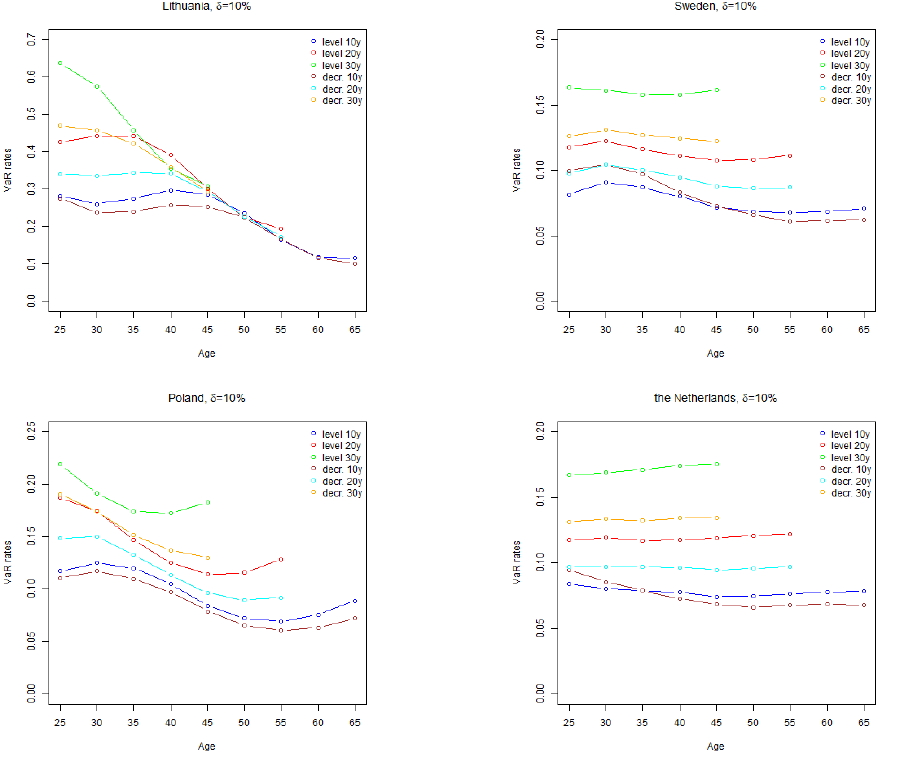
Figure 4. Calculated one-year VaR rates (parameter δ = 10%) at policy inception by country for different ages at policy inception, three different terms to maturity (10 years, 20 years and 30 years) and two benefit formulas (level sum assured and sum assured decreasing with